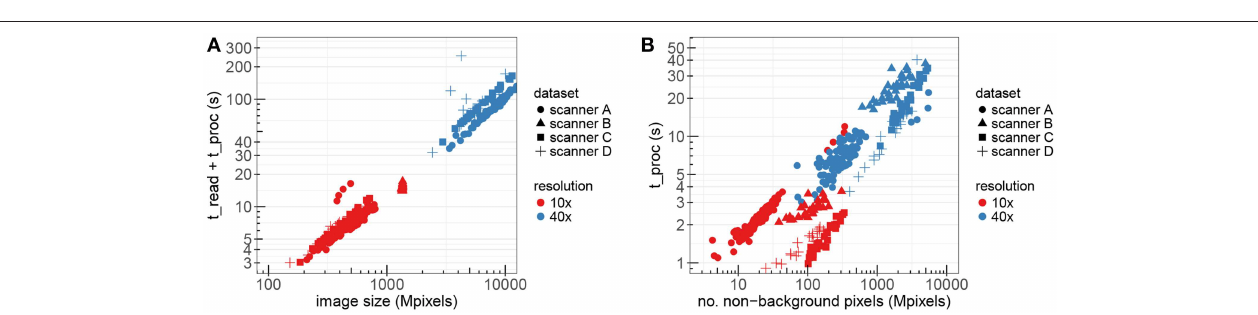
FIGURE 10 | The performance of fast_sn on WSIs from different datasets and resolution factors. (A) Read and processing time as a function of the image size. (B) Processing time only as a function of non-background pixels.